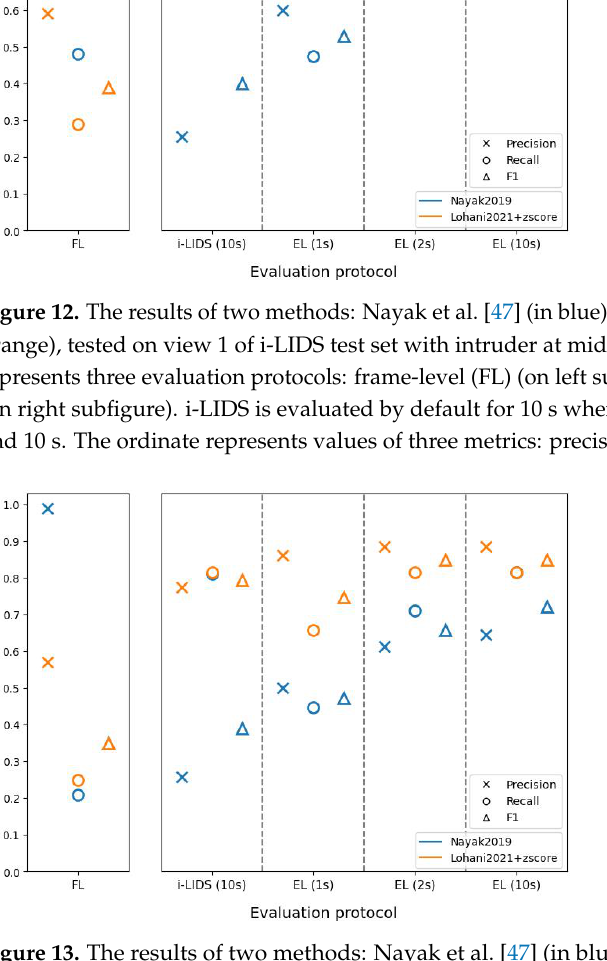
Figure 13. The results of two methods: Nayak et al. [47] (in blue) and Lohani et al. [6] with z-score (in orange), tested on view 1 of i-LIDS test set with intruder at far distance from camera. The abscissa represents three evaluation protocols: frame-level (FL) (on left subfigure), i-LIDS and edge-level (EL) (on right subfigure). i-LIDS is evaluated by default for 10 s whereas, for EL, we show results for 1, 2 and 10 s. The ordinate represents values of three metrics: precision, recall and F 1